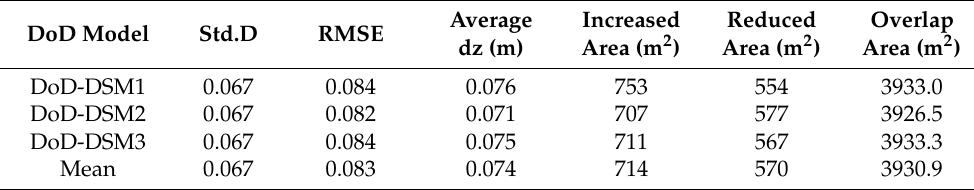
Table 3. Statistical table of the DoD model transformation detection.